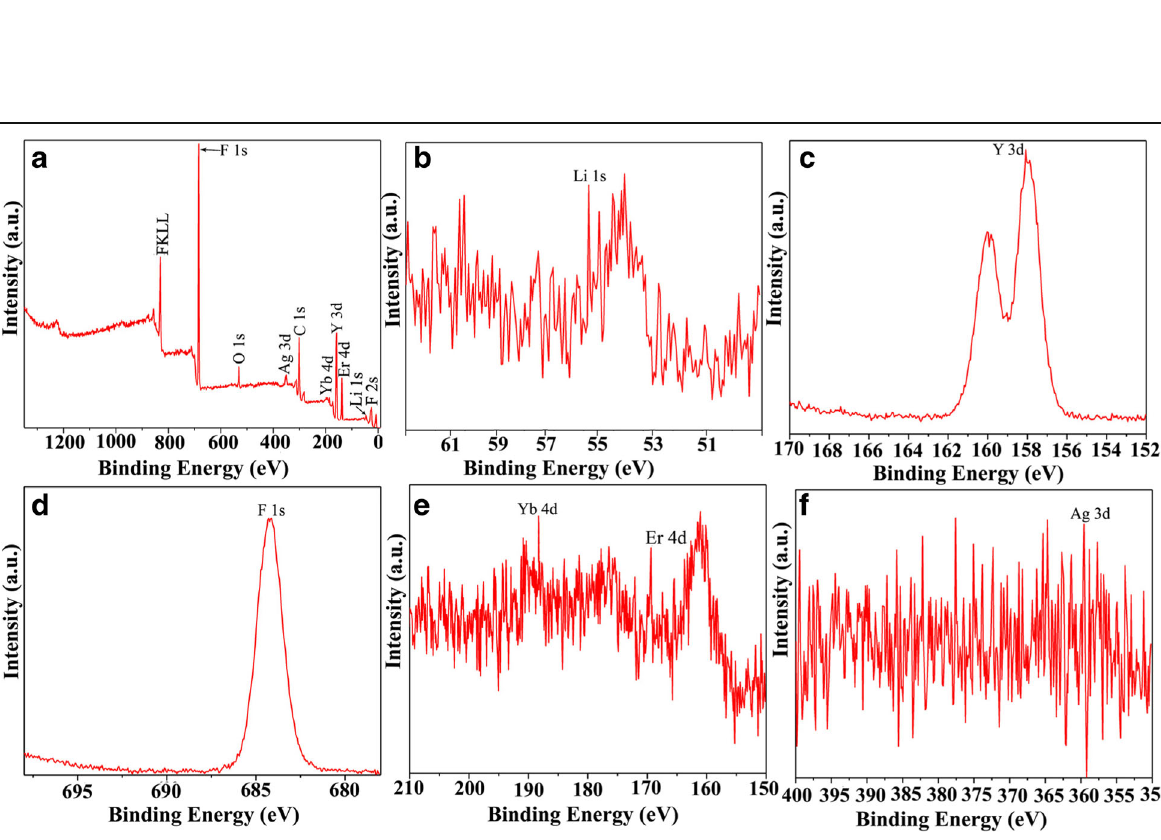
Fig. 4 XPS a survey, b Li 1s, c Y 3d, d F 1s, e Yb and Er 4d, and f Ag 3d spectra of LiYF 4 :Yb 3+ /Er 3+ NPs doped with